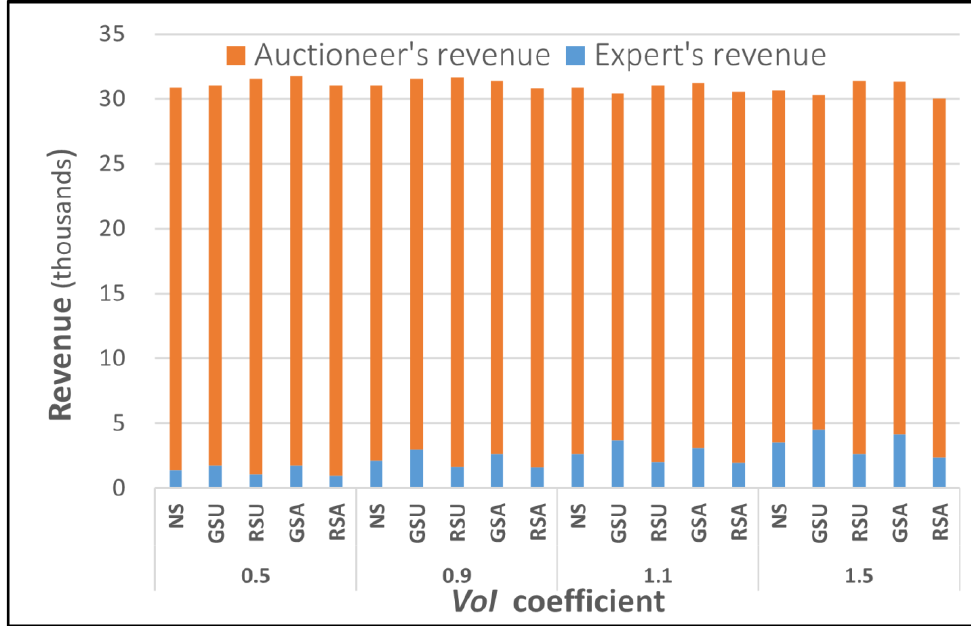
Figure 11. Social welfare as a function of the information cost.